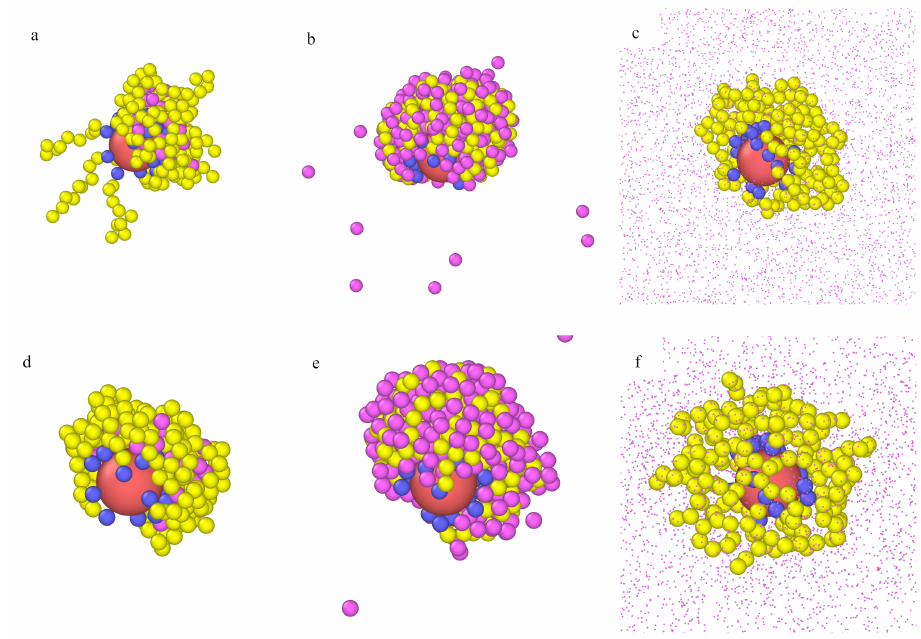
Figure 10. Examples of the equilibrium configurations of hairy particles immersed in fluids of different densities ρ 0 = 0.0001 ( a , d ), 0.001 ( b , e ), 0.1 ( c , f ) for model M1 ( a – c ), model M1a ( d – f ): f = 20, M = 20 ( a – c ), f = 20, M = 10 ( d – f ). Other parameters: σ c = 4 σ , f = 20, M = 10 and ε Ps = 3.0 ε . The red sphere represents the core, and blue spheres correspond to bonding segments, yellow spheres and pink spheres represent the remaining segments and fluid particles P, respectively. For clarity, particles P are represented by points (size ratios are not kept) in parts ( c , f